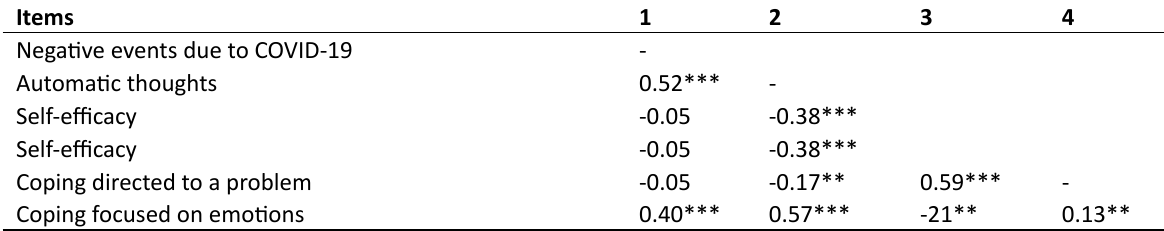
Table 2b. Pearson’s correlation coefficients between examined variables